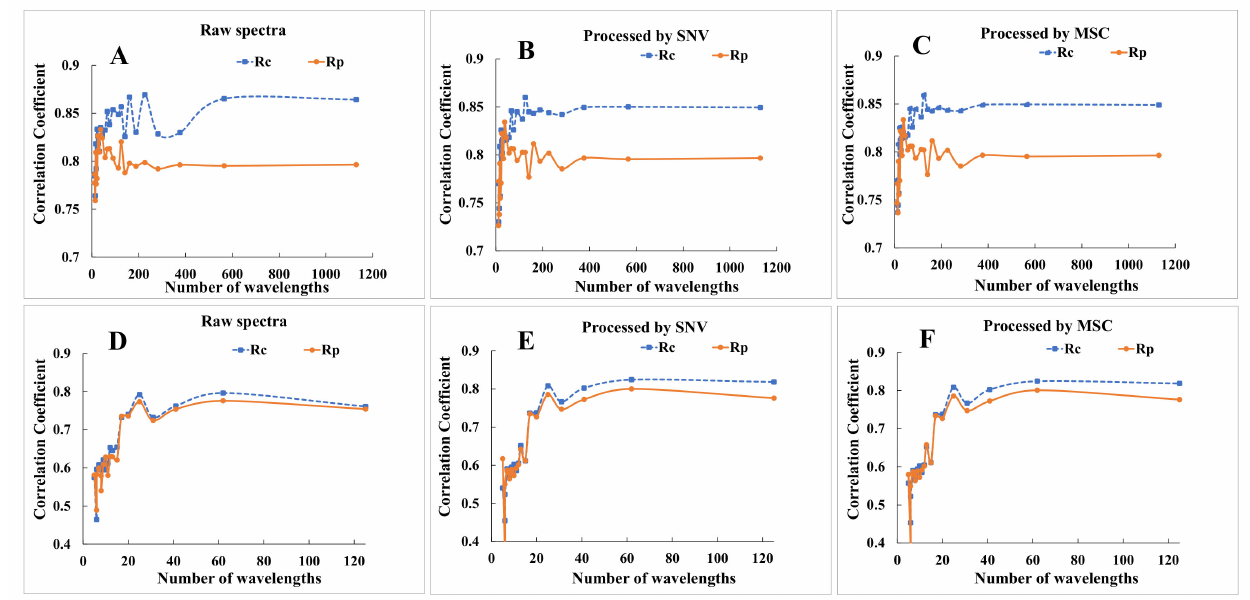
Figure 3. Modeling result of fat after sampling interval shortening and pretreating with SNV and MSC, ( A – C ) are the modeling results based on the spectral region of 400–1050 nm after in- creasing sampling interval and different pre-treatment methods; ( D – F ) are the modeling results based on the spectral region of 900–1700 nm after increasing sampling interval and different pre-treatment